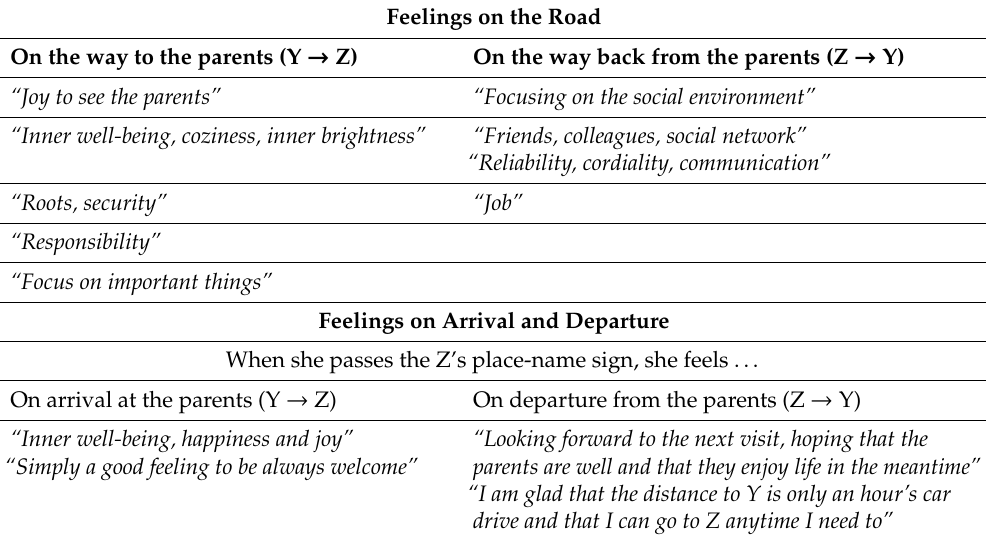
Table 3. Feelings of being on the